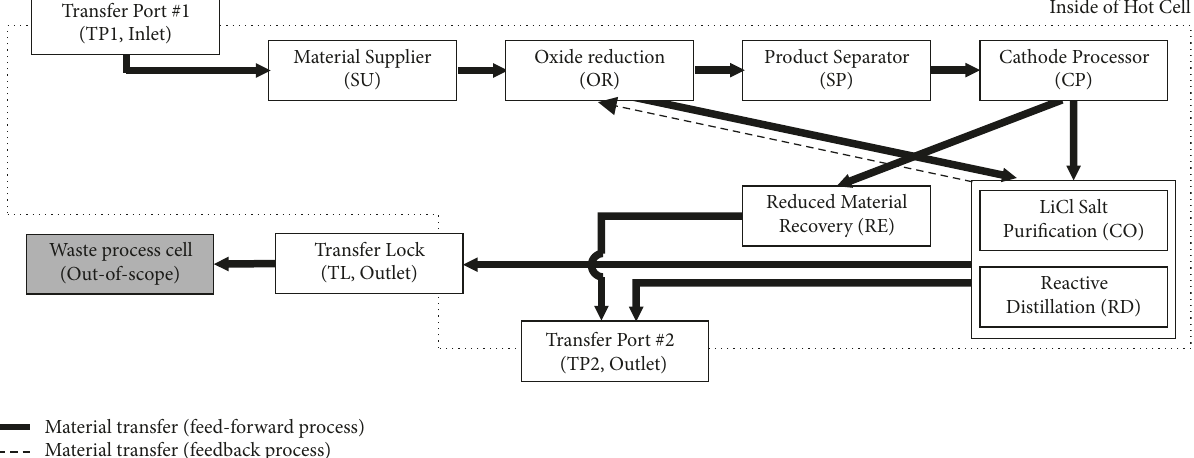
Figure 1: Oxide reduction process performed in the hot cell at the target